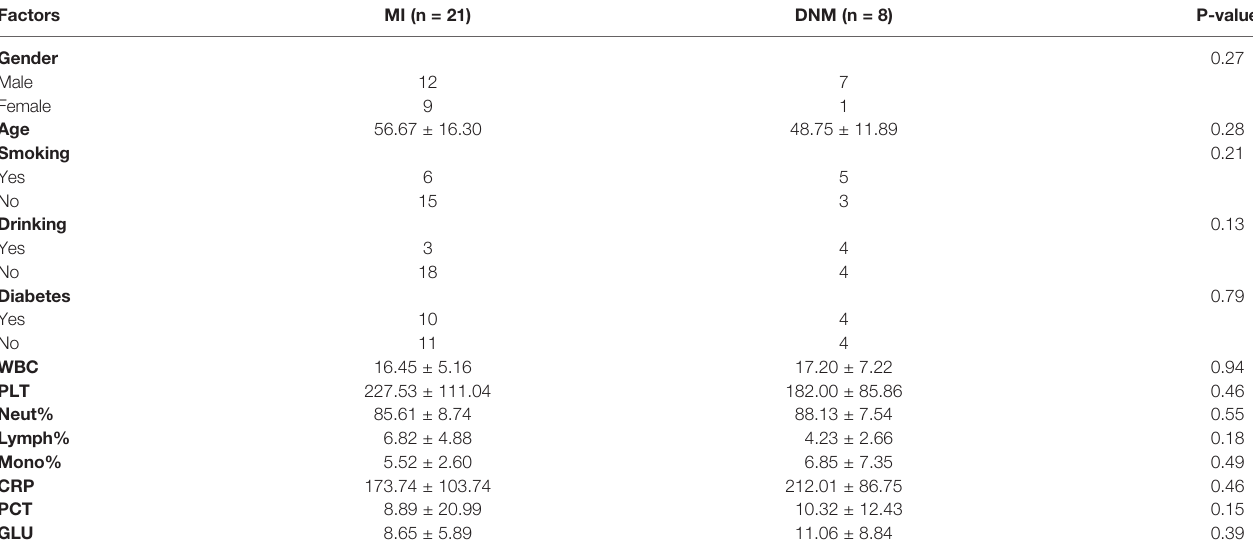
TABLE 1 | Clinical information of the two sample groups. Factors Gender